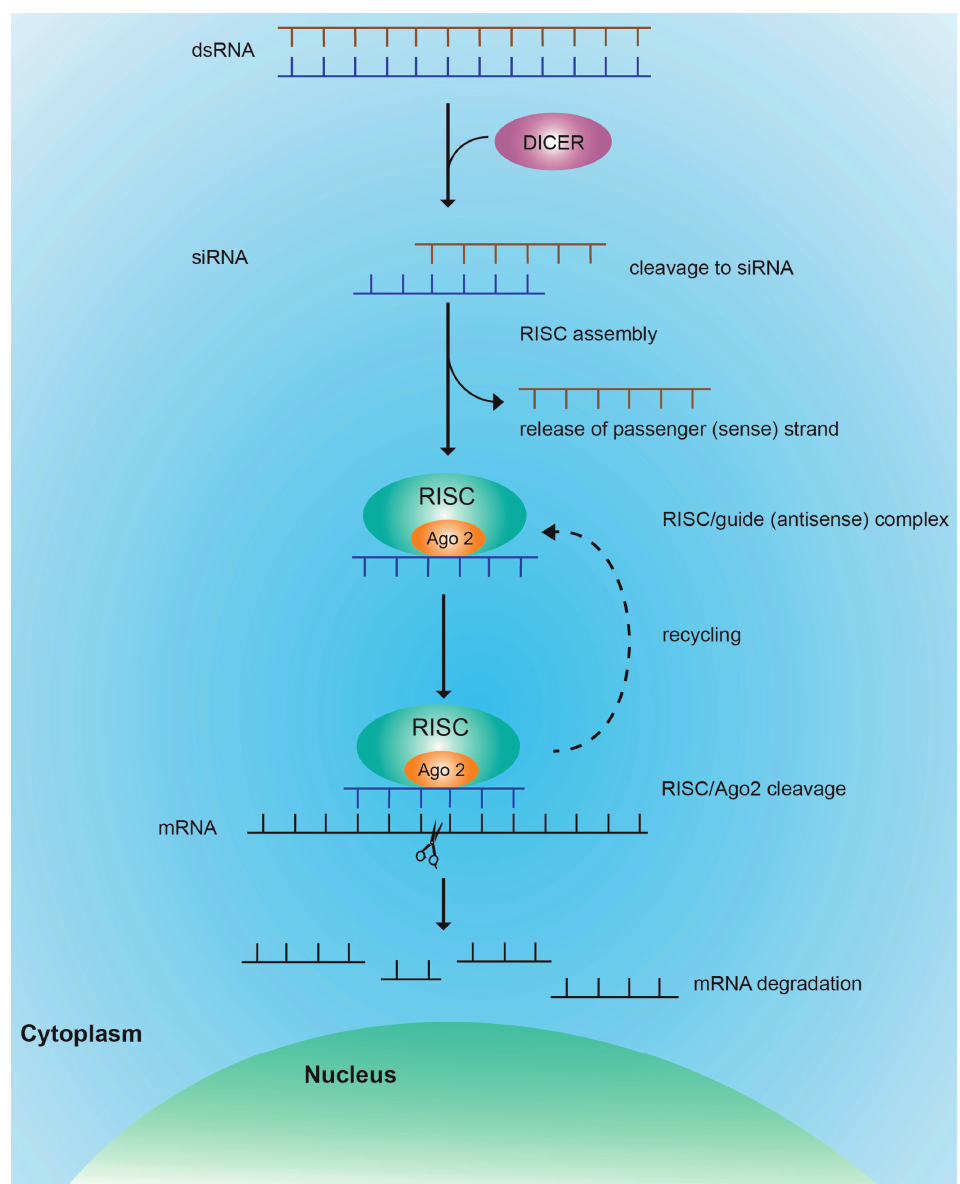
Figure 5. Schematic representation of siRNA mediated gene silencing. Long dsRNA is cleaved by enzyme Dicer into 20–30 bp siRNA, which consists of a passenger strand (sense) and a guide strand (antisense). Alternatively, a mature siRNA containing a 5 ′ phosphate and a two-nucleotide overhang at the 3 ′ end can be delivered to cells. The multiprotein enzyme complex RISC recognizes the siRNA in the cytoplasm, unwinds the duplex siRNA and incorporates the guide strand (antisense) while the passenger strand is released. RISC then uses the guide strand to specifically target mRNA. For perfectly matching targets, the endonuclease Ago 2 within RISC induces one cleavage that takes place at position 10 upstream of the 5 ′ end. After cleavage, the siRNA-RISC complex is recycled to target other